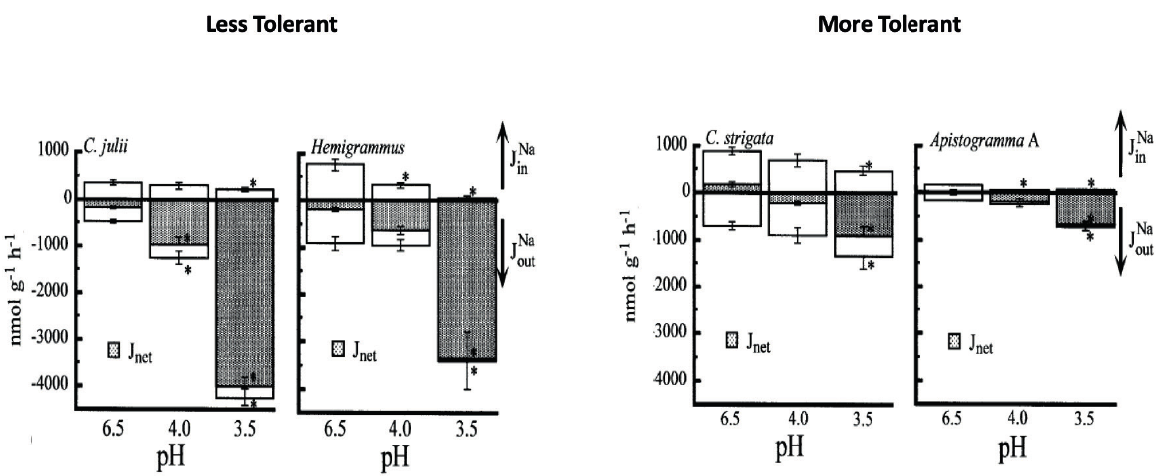
, effl ux ( ) outNa J and net fl ux ( ) net J of four species of fi sh from Rio Negro exposed to acidic water. From Figure 2 - Sodium infl ux ( ) Na in J gonzalez et al.